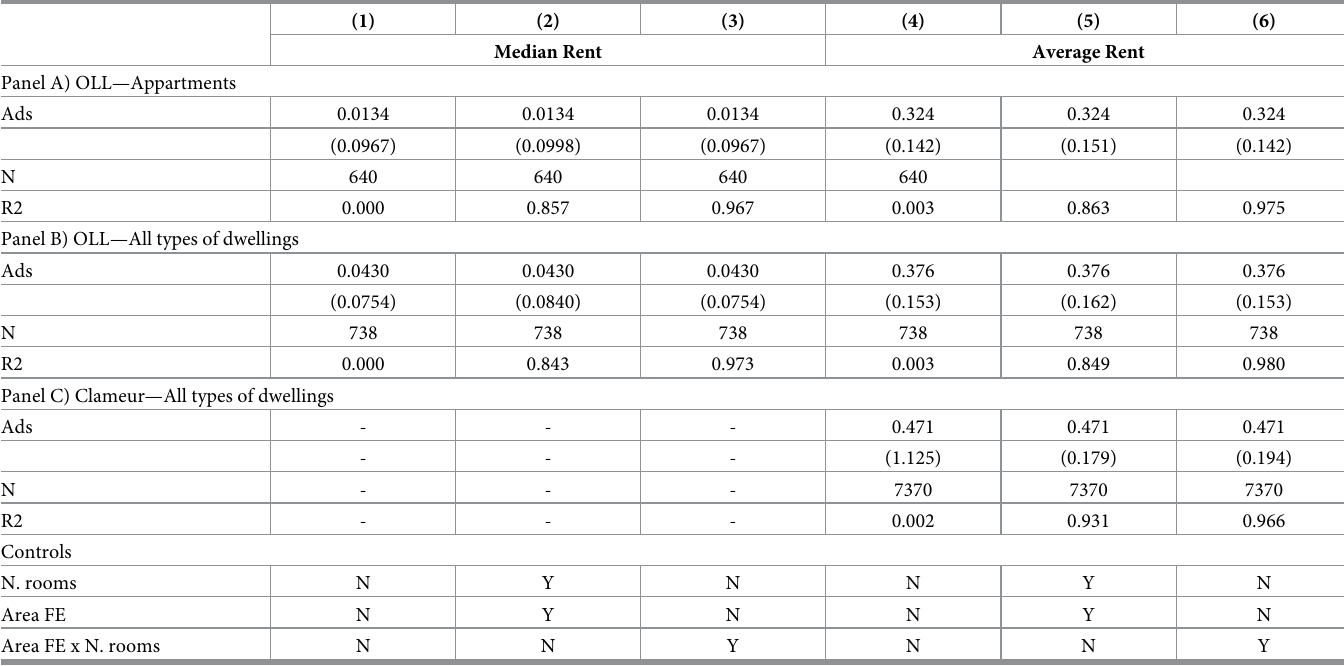
Table 5. Comparison between the statistics provided by online ads and the OLL or